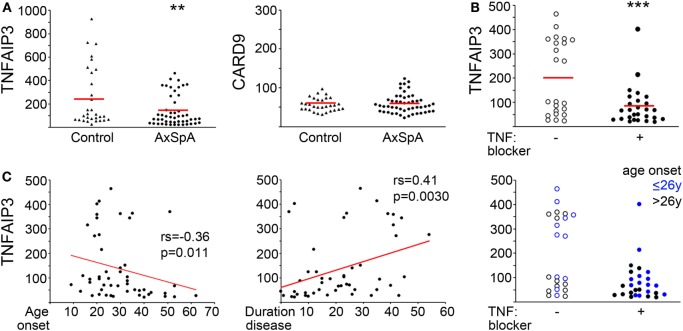
Decreased tumor necrosis factor alpha-induced protein 3 (TNFAIP3) levels in axial spondyloarthritis (AxSpA) subjects. (A) Peripheral blood-derived macrophage lysates were assessed for TNFAIP3 or CARD9 protein by ELISA. Healthy controls are denoted by triangles and AxSpA subjects by circles. The red lines designate mean expression. **T-test statistic with 1,000,000 (1 M) permutations p = 0.0085. AxSpA patient sample TNFAIP3 levels were further analyzed according to (B) current TNF blocker use (open circles for no TNF blocker and filled circles for current TNF blocker). (C) age of onset (left, years), duration of disease (middle, years) or both age of onset and TNF blocker status (right). ***p = 0.0011 by permuted T-test. Significance for age of onset and duration of disease were determined by Spearman’s correlation.